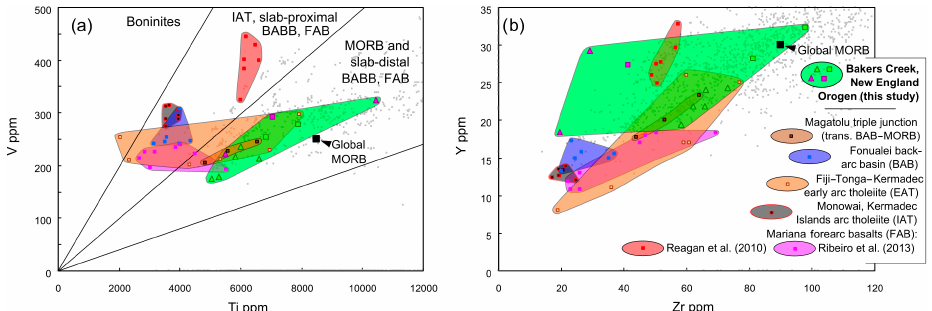
Figure 7. Ti-V and Zr-Y systematics of Bakers Creek Suite melt compositions and selected primitive melts from western Pacific arc systems (Keller et al., 2008; Reagan et al., 2010; Timm et al., 2011; Escrig et al., 2012; Ribeiro et al., 2013; Todd et al., 2012; Kemner et al., 2015). Ti-V fields from Shervais (1982) and Pearce